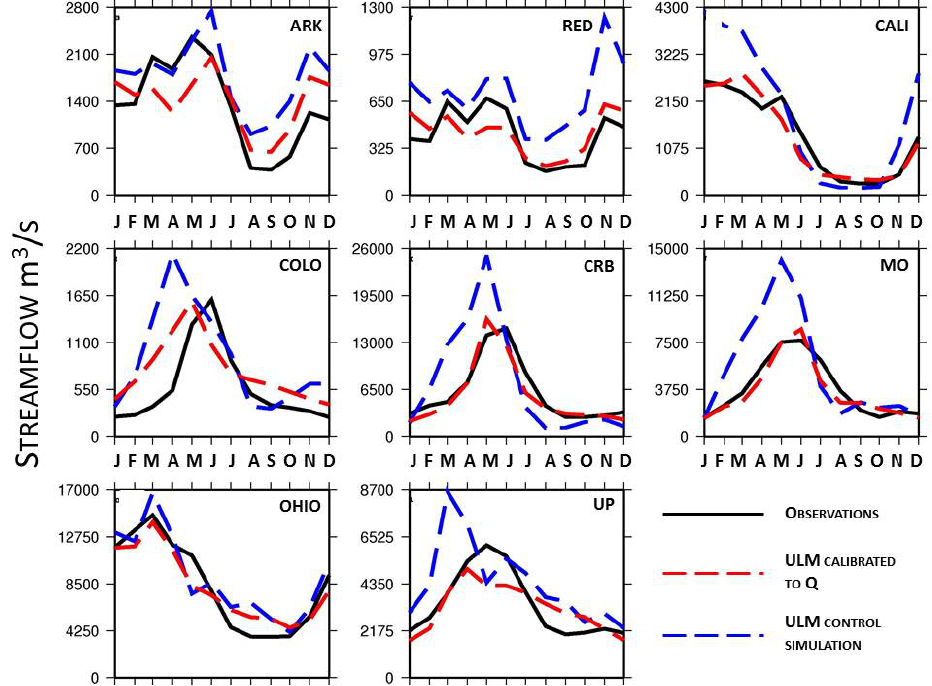
Fig. 4. Mean monthly hydrographs in m 3 s − 1 for the major basins for a 20-yr period, the beginning of which varies by basin, depending on data availability (abbreviations defined in Table